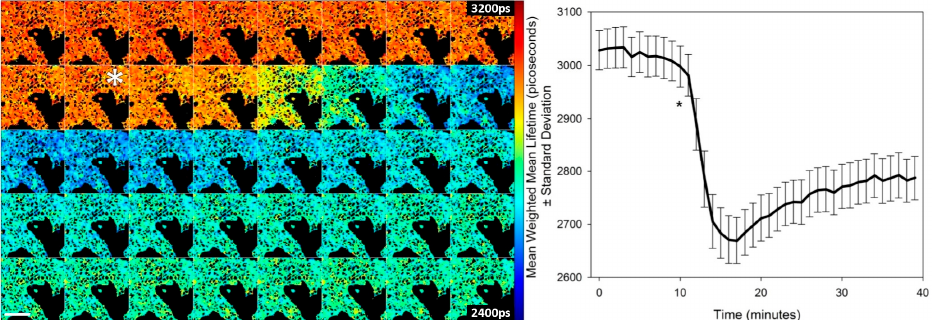
Figure 3. Time course of activation of AMPK by 991. ( Left ) time course montage of confocal TCSPC FLIM maps of T2AMPKAR-NES weighted mean fluorescence lifetimes, an image was acquired each minute; ( Right ) average weighted mean T2-AMPKAR-NES donor fluorescence lifetime in response to addition of 50 µM 991. The asterisk indicates the point of compound addition. Lifetimes are shown in picoseconds (shown in image) Scale bar = 100 µm.